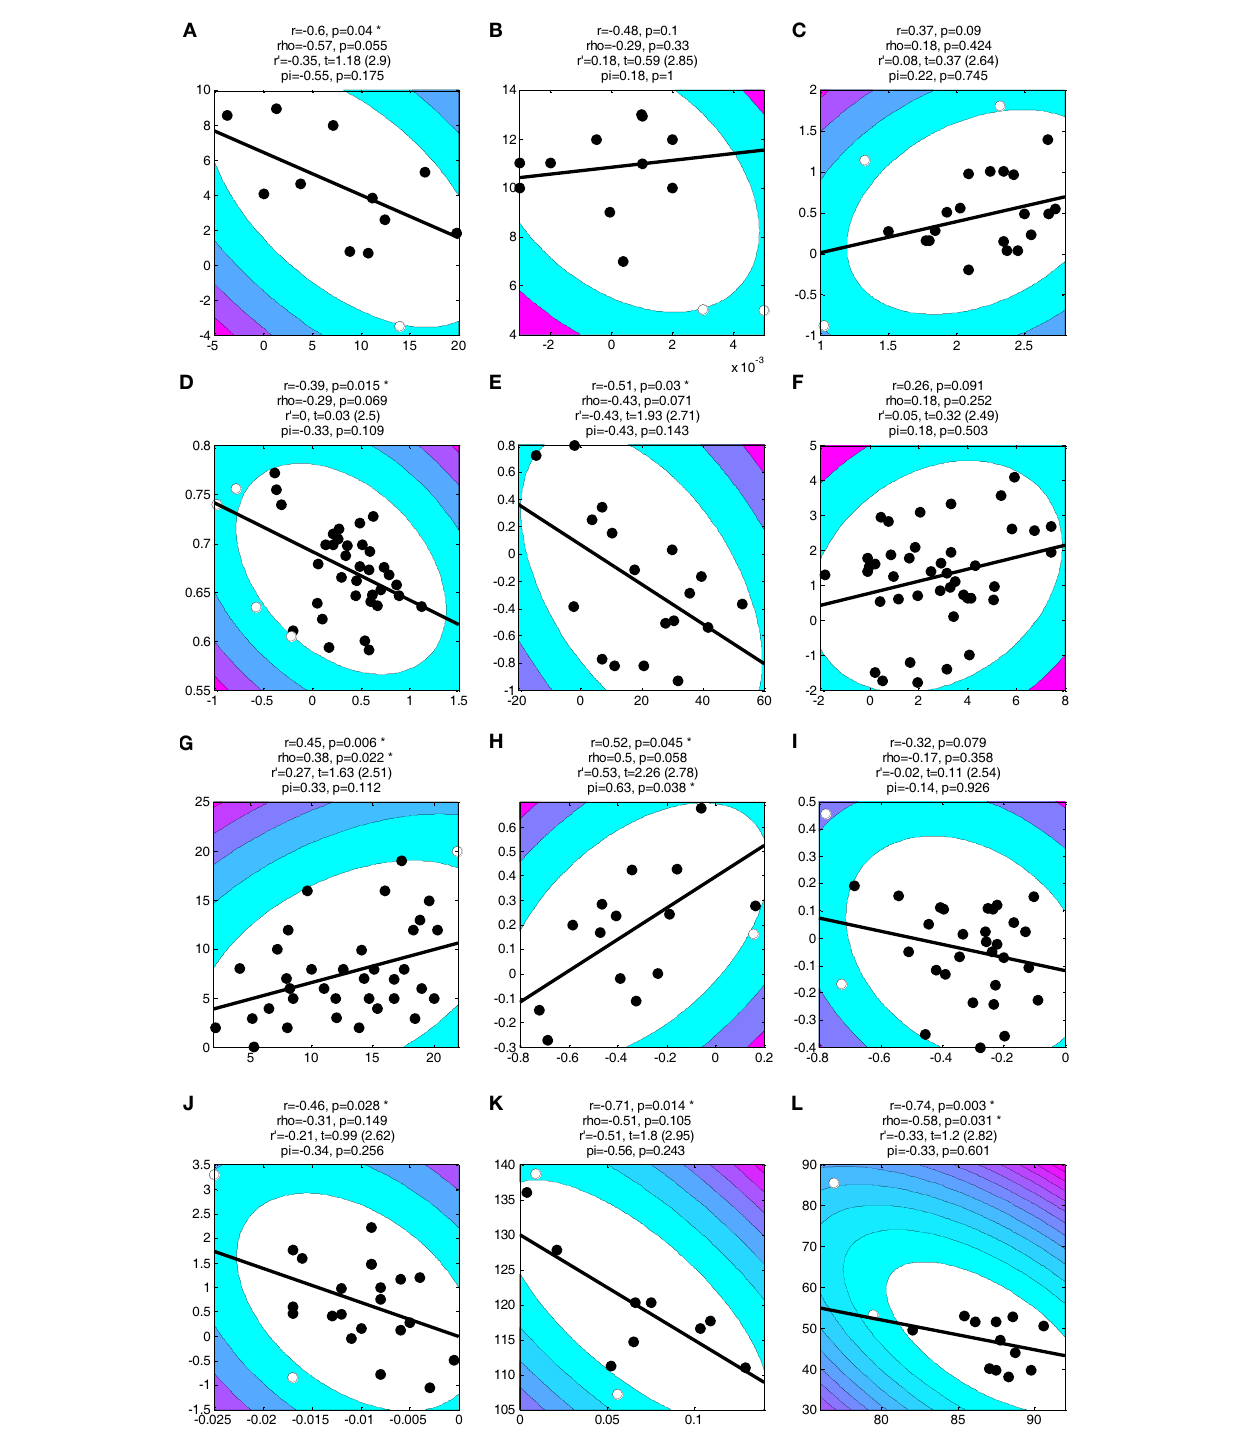
Figure A2 | Data shown in Figure A1 in Appendix of rousselet and Pernet’s article. All conventions are as in Figure 1C